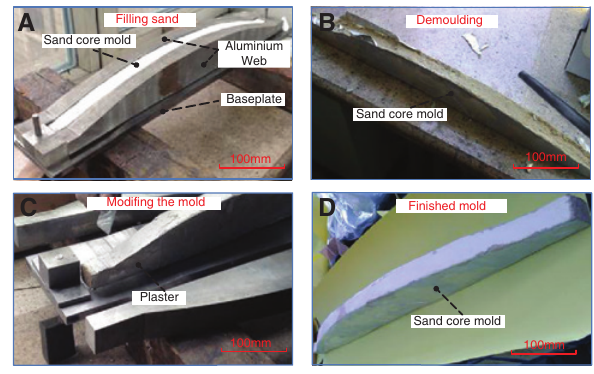
thus, it is possible to make a structure with a small enter port and a large inner cavity. Figure 8 shows the manufac- turing details of the sand-core mold. The specific process is as follows: First, we mixed polyving akohol with water at a mass ratio of 1:10. Then, the mixture was heated at the mixture with sand particles in the mold as shown in Figure 8A. Second, we heated the whole system in an oven at 120 ° C for 20 h to evaporate the water and then polyving akohol can adhere the sand particles during the